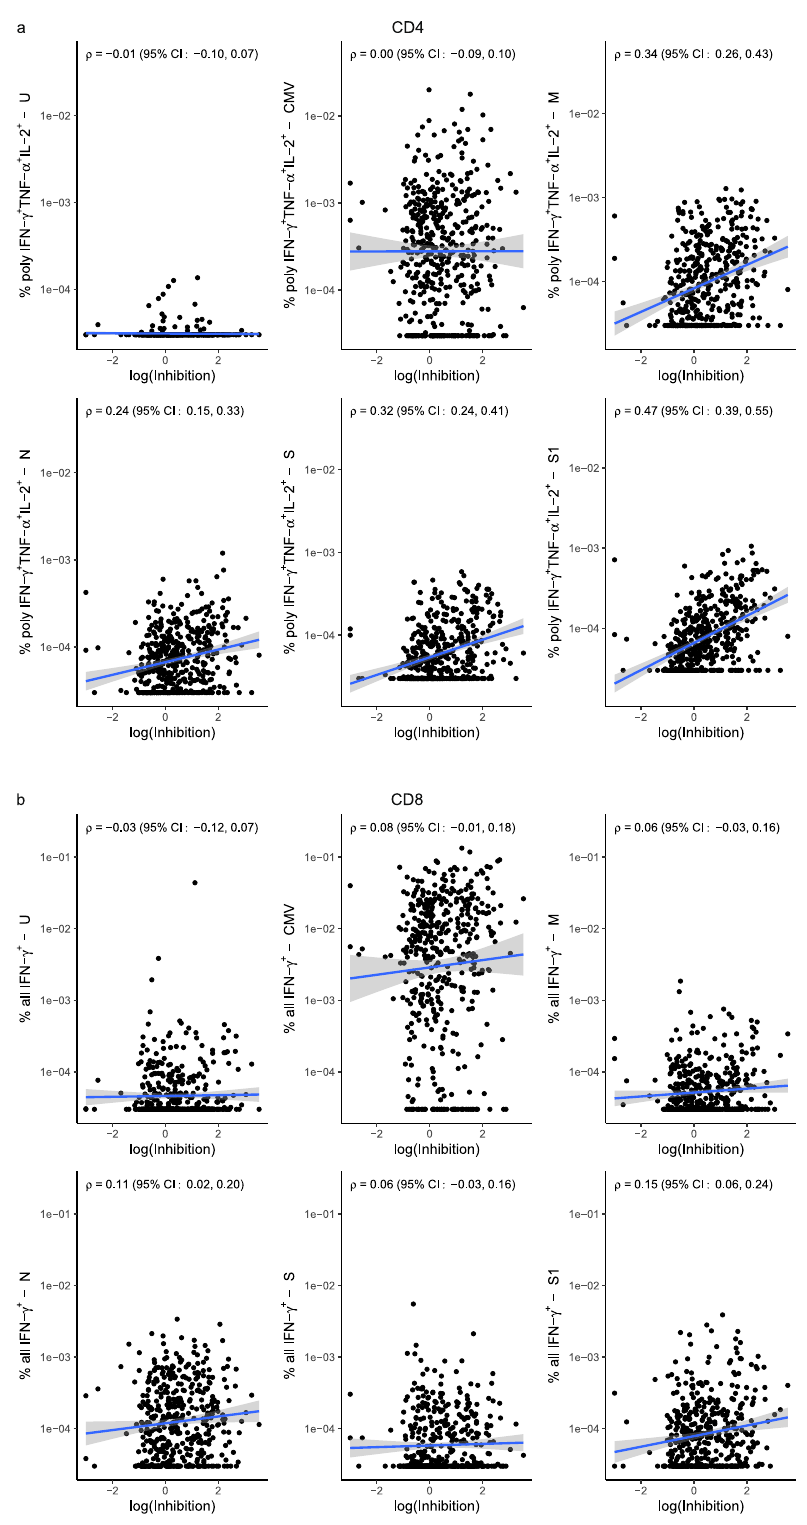
Fig. 5 SARS-CoV-2 reactive CD4 + and, to a lesser extent, CD8 + T-cell responses correlate with antibody levels. Scatter plot show a correlation between a polyfunctional CD4 + as well as b all IFN- γ + CD8 + T-cells and functional antibody responses. Inhibition of the antibodies was measured using an MSD-ECLIA-based ACE2 blocking assay and re fl ects how well the plasma antibodies inhibit binding between soluble ACE2 and plate-bound S1-RBD. Inhibition ef fi cacy of the antibodies is given on a log scale on the X-axes and percentage a polyfunctional CD4 + T-cells out of all CD4 + T-cells ( n = 456 convalescent SARS-CoV-2 cases) and b all IFN- γ + CD8 + T-cells out of all CD8 + T-cells are given on the Y-axes ( n = 454 convalescent SARS-CoV-2 cases). The solid blue line indicates the logistic-regression line and the gray area around the blue line indicates the 95% con fi dence intervals (CI). The correlation between T-cell responses and functional antibody responses shown in a , b was estimated using Spearman ’ s correlation coef fi cient and a Jackknife method was used to calculate con fi dence